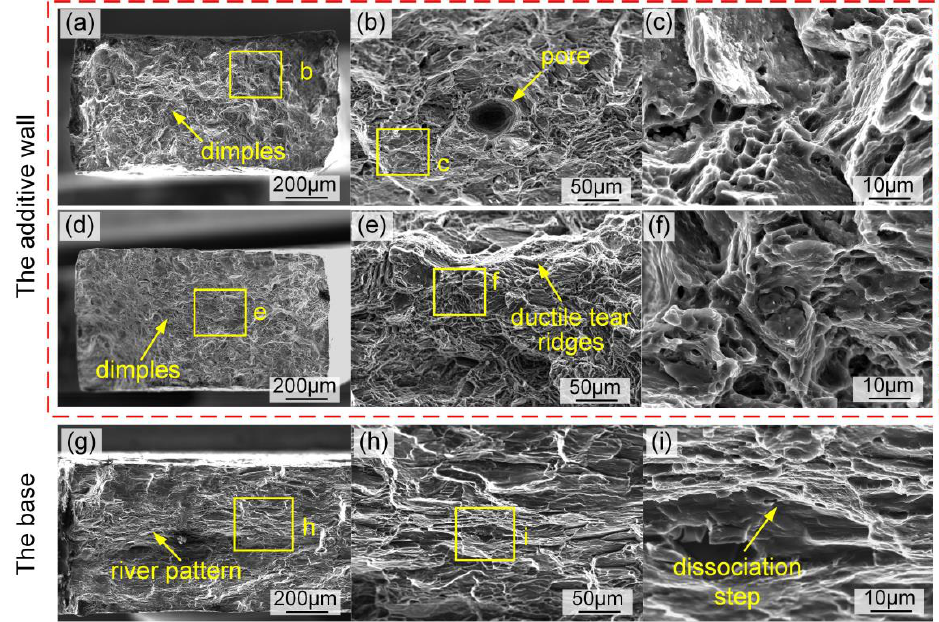
Figure 12. SEM-SE fracture surface morphology. ( a – c ) the upper part of the additive wall; ( d – f ) the lower part of the additive wall; ( g – i ) the base.